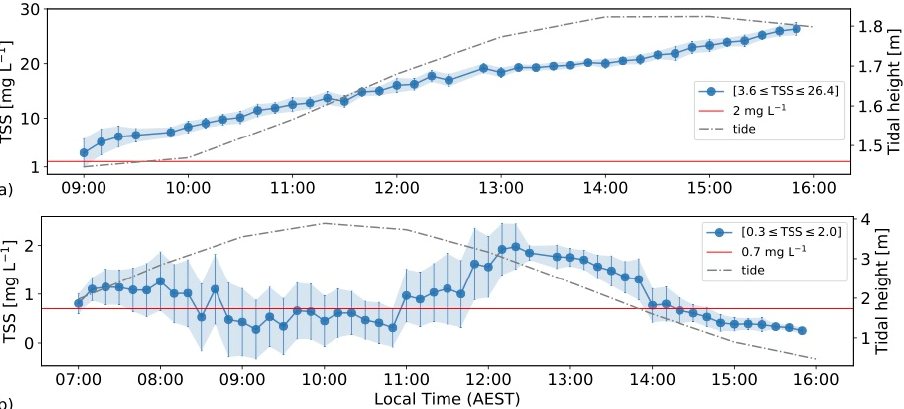
Figure 8. Time series of 10 min Himawari-8-derived TSS at the mouth of the Burdekin River during the floods of February 2019 ( a ) and in the southern GBR reef matrix in November 2016 ( b ), as shown in Figure 7. Error bars represent intra-pixel standard deviations. Guideline thresholds for inshore (2.0 mg L − 1 ) and mid-shelf (0.7 mg L − 1 ) waters are marked in red. Note the different time ranges in each figure.